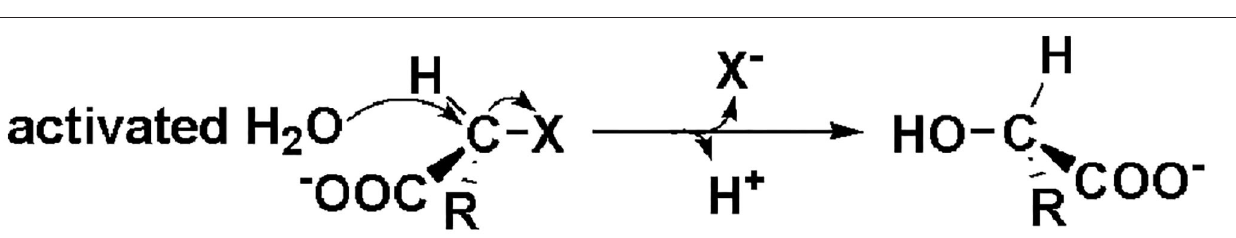
FIGURE 4 | Reaction mechanism of DL-DEXi (Nardi-Dei et al.,